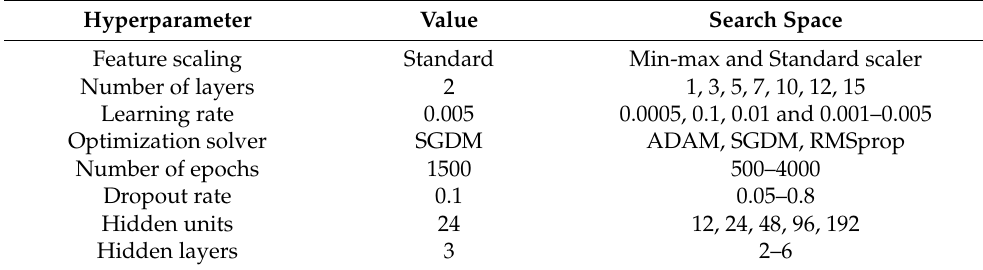
Table 3. Hyperparameter